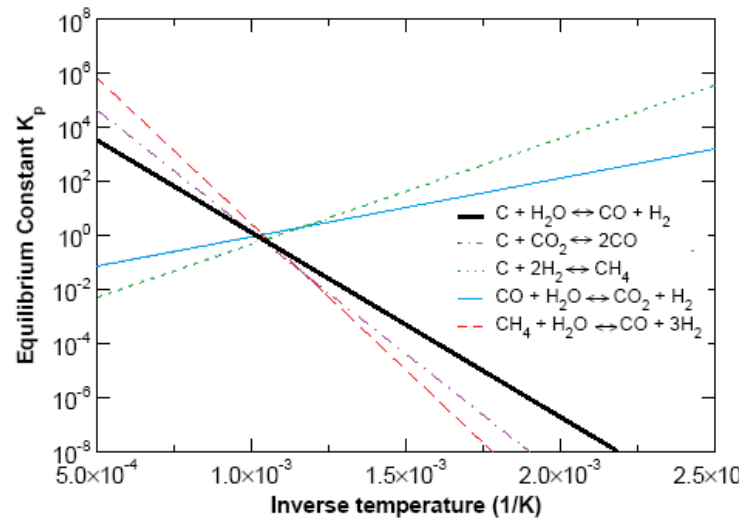
Figure 2. Equilibrium constant Kp as a function of temperature for some reactions in coal gasification